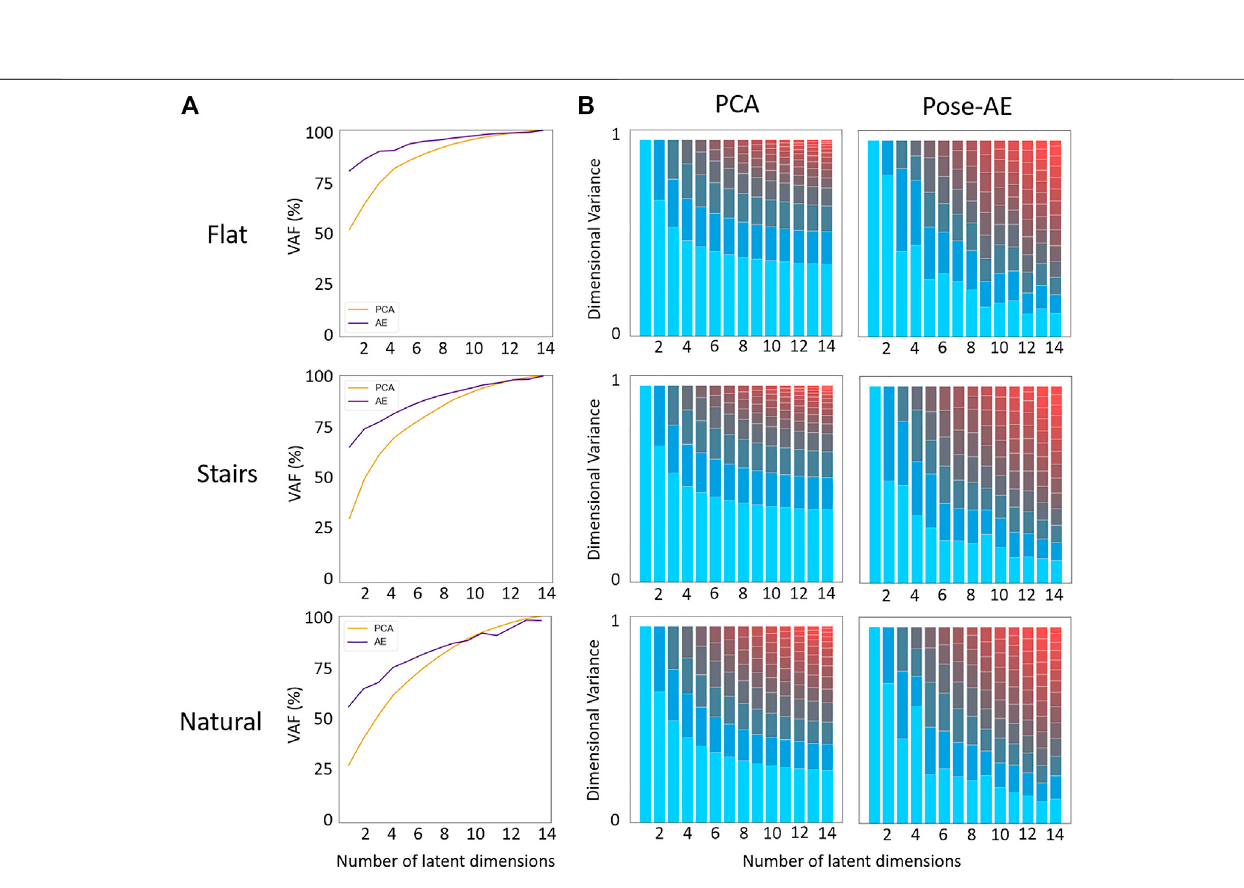
FIGURE3|(A) Pose-AEcaptured morevariationinthedatathanPCAforallthreedatasets. (B) DimensionalvarianceismoreevenlydistributedwithPose-AEthan PCA. The effect is most pronounced with higher dimension latent spaces. The largest dimension by variance has been highlighted blue to facilitate comparison across PCA and